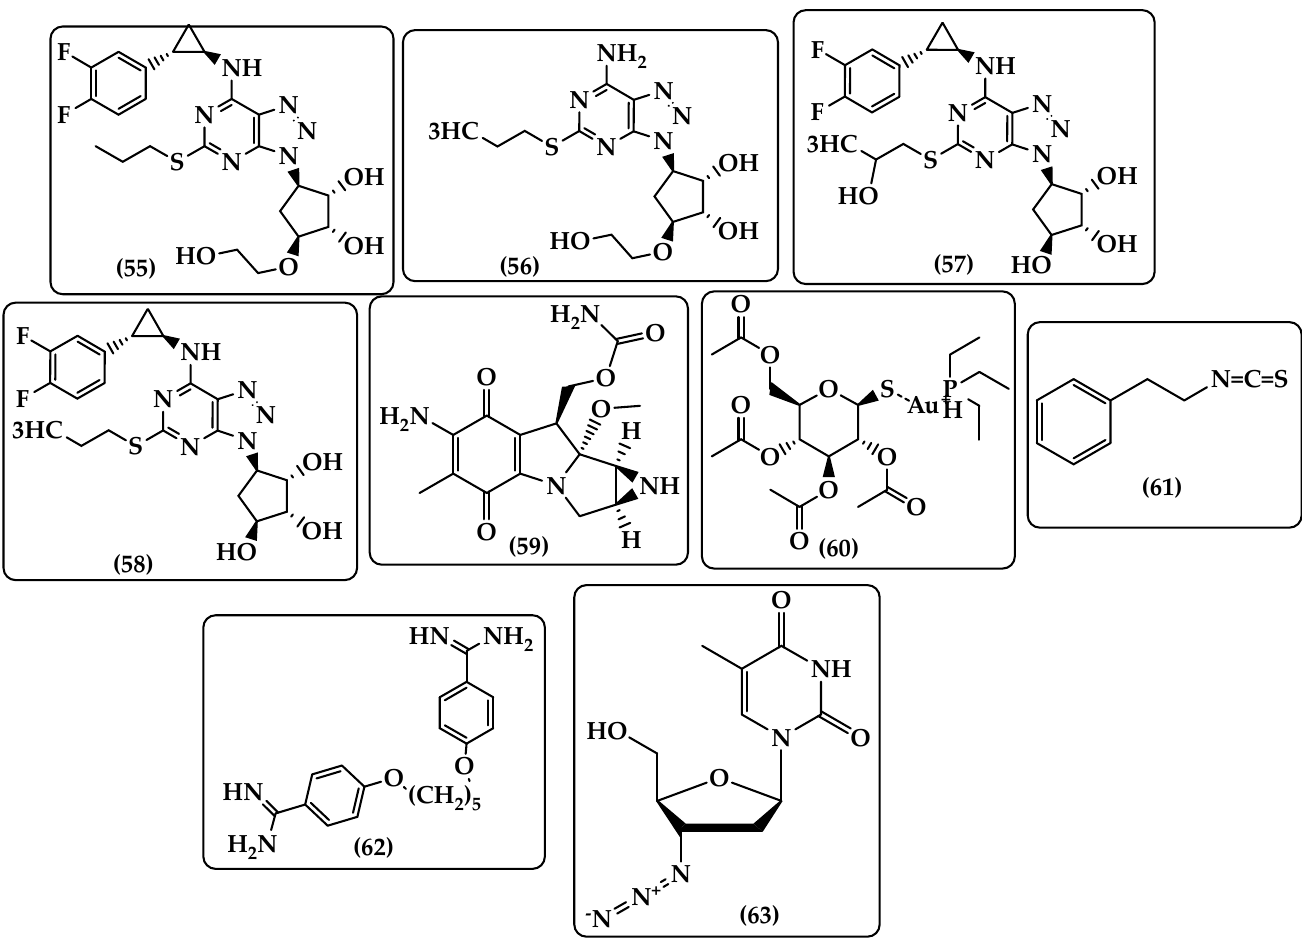
Figure 12. Chemical structure of ticagrelor ( 55 ), M5 AR-C133913 ( 56 ), M7 ( 57 ), M8 AR-C124910 ( 58 ), Mitomycin C (MMC) ( 59 ), aurano fi n ( 60 ), pentamidine ( 62 ), and zidovudine (AZT) ( 63